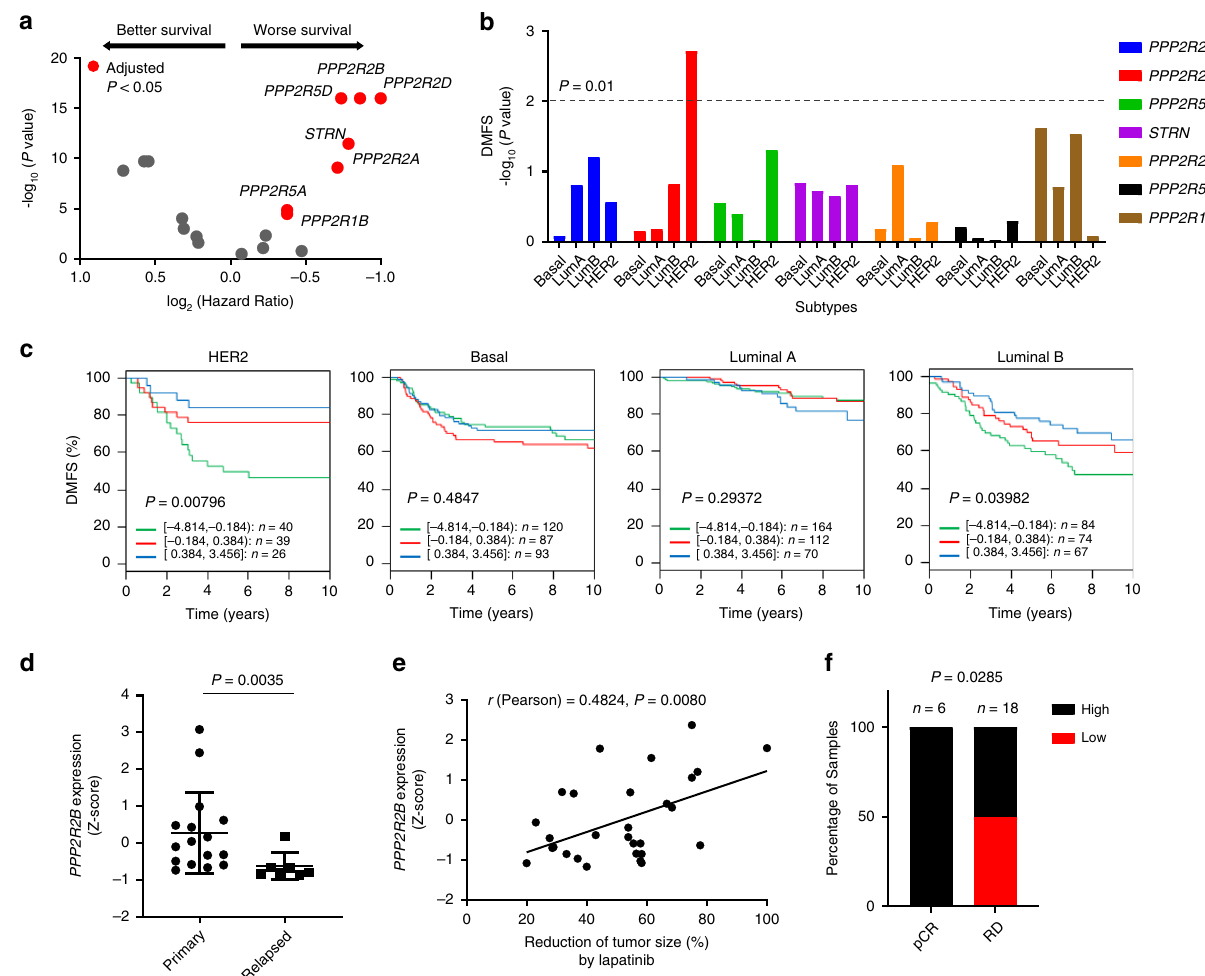
Fig. 1 PPP2R2B downregulation confers risk of disease progression and poor treatment response to anti-HER2 therapy. a Volcano plot illustrating hazard ratio (log 2 ) compared with P value ( − log 10 ) between expression of PP2A members and relapse-free survival (RFS) in breast cancer. Members whose downregulation is signi fi cantly (Bonferroni-adjusted P value < 0.05) prognostic are highlighted in red, and their gene names are indicated next to their representative dots. Data were collected from KM Plotter (http://kmplot.com/analysis/). The computed based performing thresholds which are used as cut-offs were auto-selected for the percentiles of the subjects between the low and high gene-expression groups. b P value ( − log 10 ) between expression of the indicated subunit genes and distant metastasis-free survival (DMFS) in different breast cancer molecular subtypes. The molecular subtypes presented include basal-like (Basal), luminal A (LumA), luminal B (LumB), and HER2 + (HER2). P < 0.01 is considered statistically signi fi cant. c Kaplan – Meier curves comparing DMFS of breast cancer patients with tumors expressing the indicated levels of PPP2R2B in the indicated breast cancer subtypes. Data from b and c were collected from the GOBO database (http://co.bmc.lu.se/gobo/gsa.pl). P values in a to c were calculated with two-sided log-rank test. d RT-qPCR measuring expression of PPP2R2B in treatment-naïve primary HER2 + breast cancer tumors ( n = 16) vs. distant metastatic tumors that recurred after a trastuzumab-containing regimen ( n = 7). Data are expressed as means ± s.d. P value was calculated with two-sided Mann – Whitney